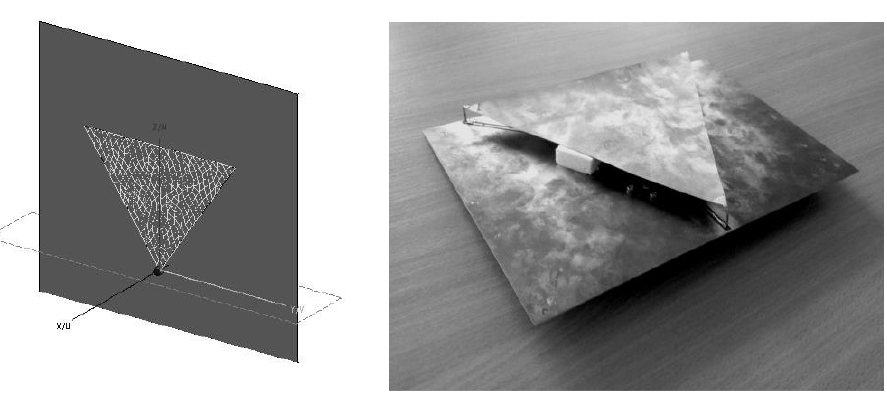
Fig. 2. Antenna model in package FEKO. Fig. 3. Sample of the manufactured antenna.